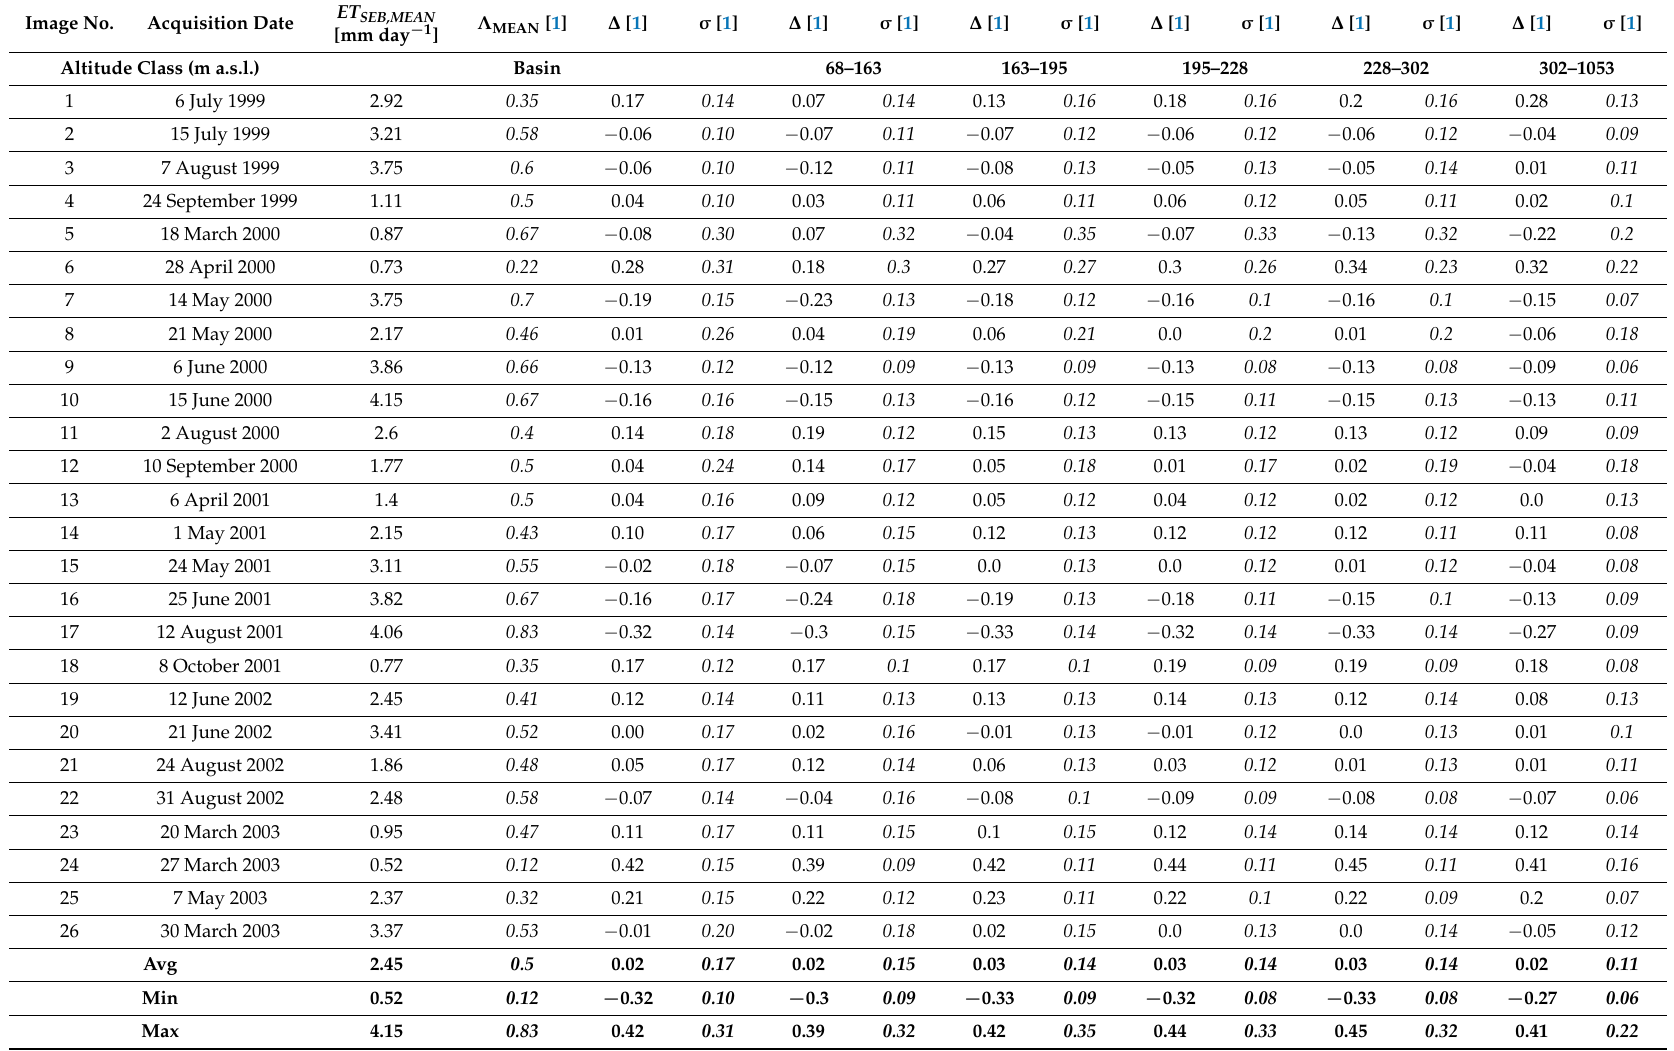
Table 2. Variability between Λ INT and instantaneous Λ for altitude